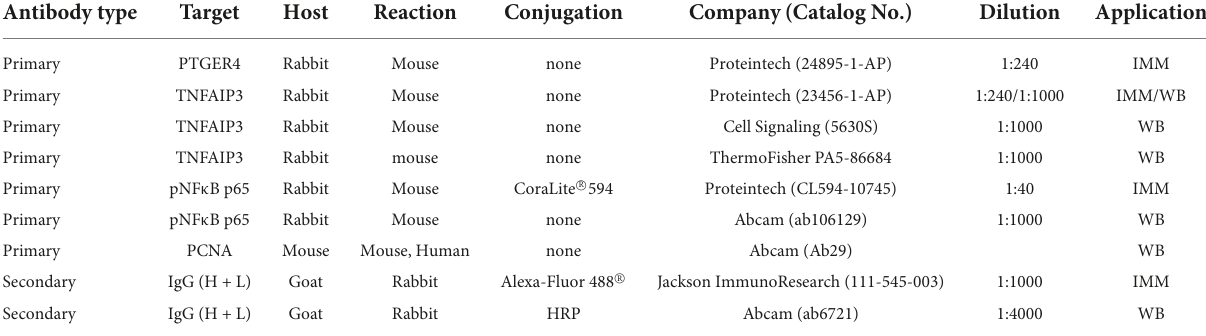
TABLE 1 Antibodies used in this